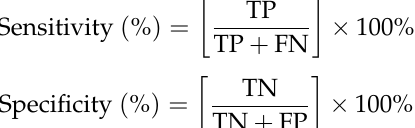
86.4 Table 2. External validation results (confusion matrix) obtained by the PLS-DA model (Model 2) using blind samples for the targeted approach (individual features). Real Classification Acorn-Fed